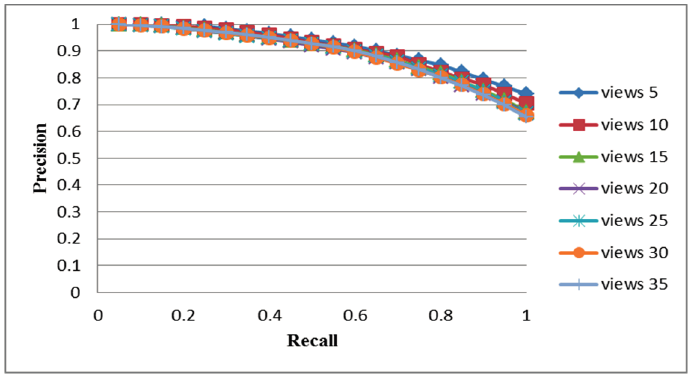
Figure 5. Average precision-recall curves of the proposed method for different values of views.